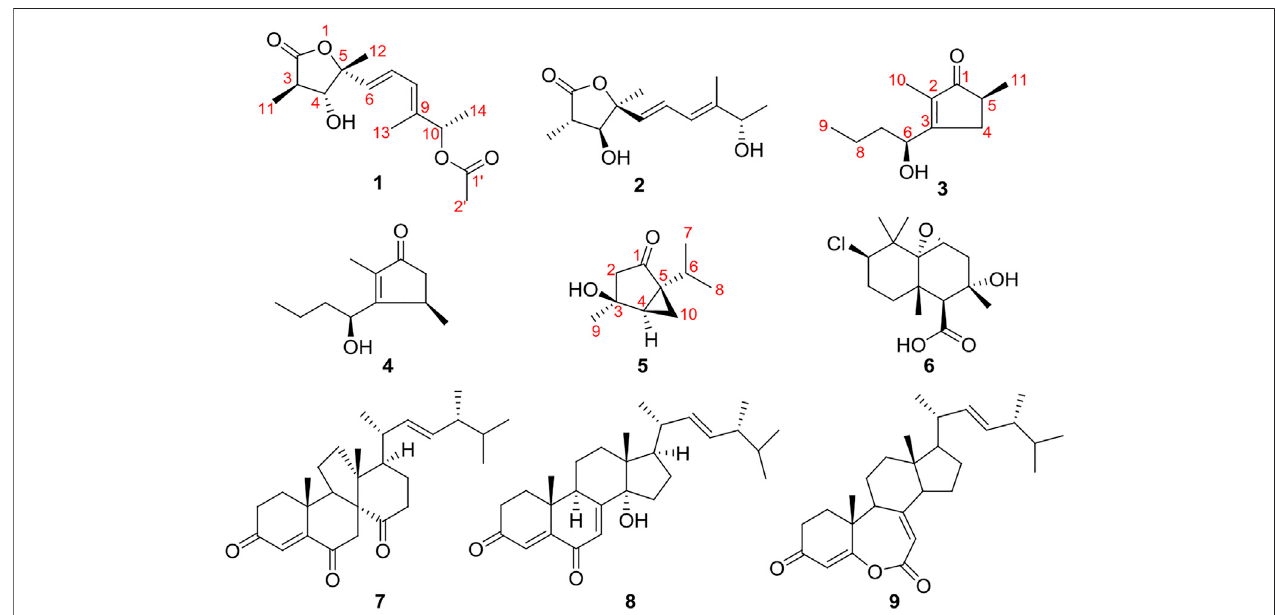
FIGURE 1 | Chemical structures of compounds 1 – 9